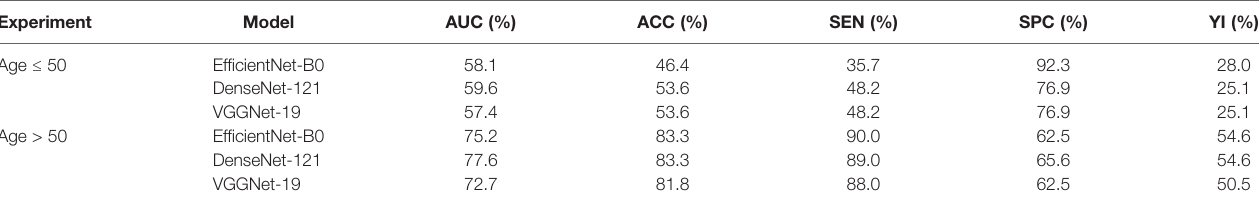
TABLE 3 | Diagnostic performance of BI-RADS lexicon model for differentiating breast cancer subtypes in the main cohort. Experiment Luminal A vs. non-luminal A TABLE 4 | Diagnostic performance of deep convolutional neural network model for differentiating luminal A and non-luminal A subtypes based on patient age in the main cohort. Experiment